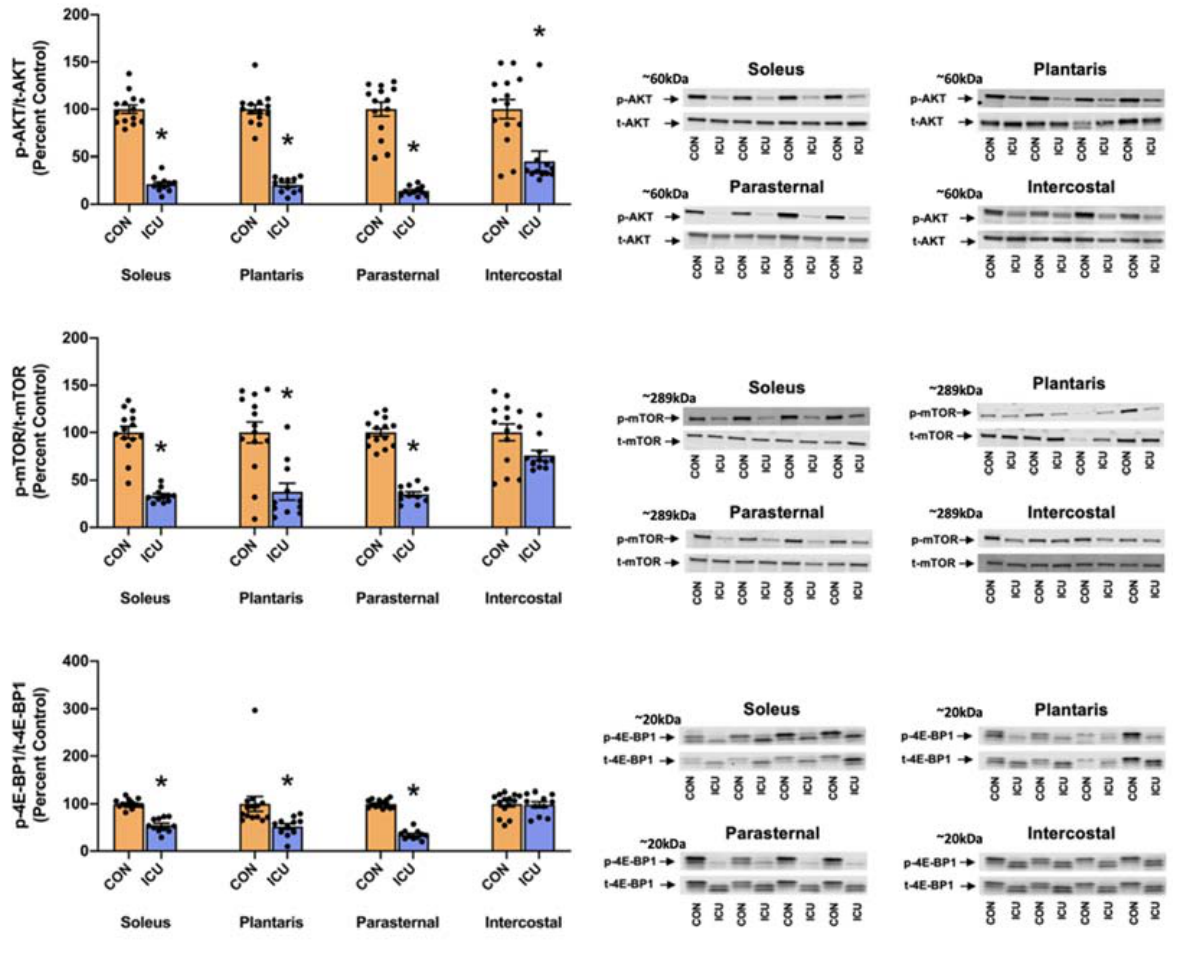
Figure 2. Muscle protein synthesis signaling. Ratio of p ‐ AKT/t ‐ AKT (Ser 473), p ‐ mTOR/t ‐ mTOR (Ser 2448) and p ‐ 4E ‐ BP1/t ‐ 4E ‐ BP1 (Thr 37/46) in the soleus, plantaris, parasternal, and intercostal muscles of control, non ‐ anesthetized, non ‐ ventilated rats (CON), and rats that underwent 12 h of controlled mechanical ventilation (ICU). Representative Western blots are shown to the right of the graph. Data are presented as mean ± SEM. * significantly different vs. CON ( p < 0.05).